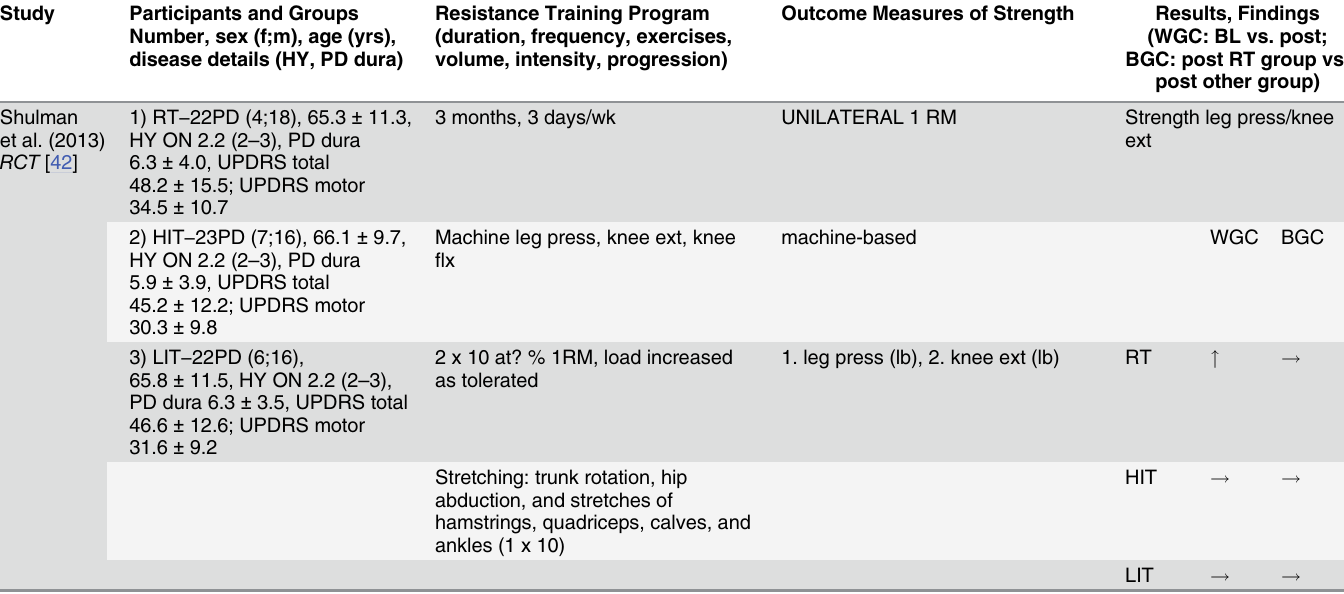
Stretching: trunk rotation, hip abduction, and stretches of hamstrings, quadriceps, calves, and ankles (1 x